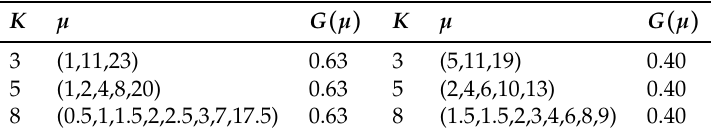
Table 4. Service intensities versus Gini’s index.